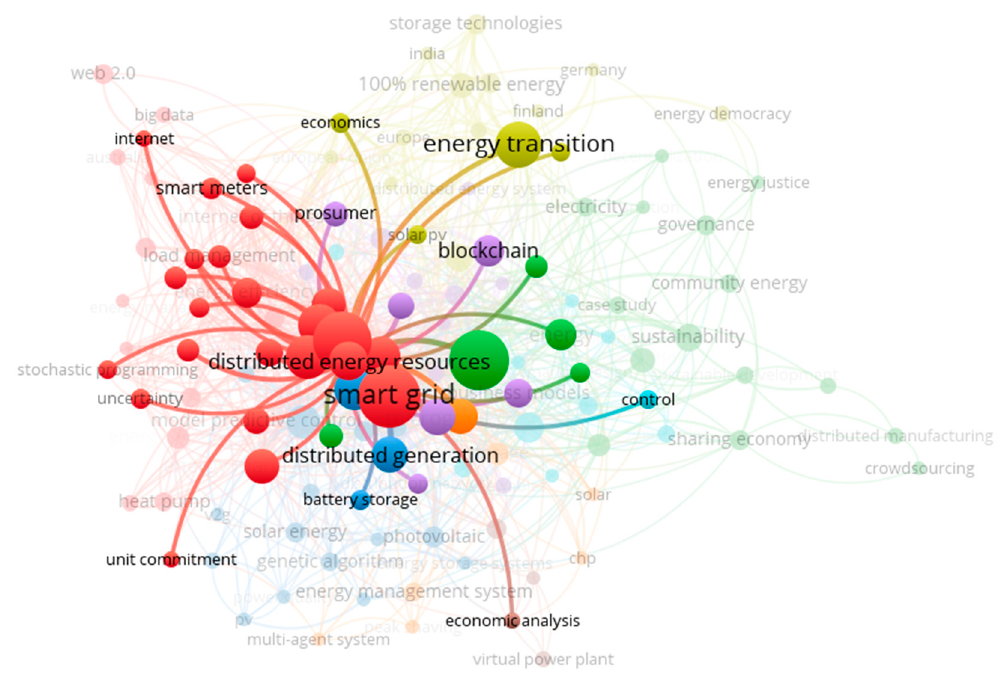
Figure 18. Highlighting the connections around ‘distributed energy resources’.